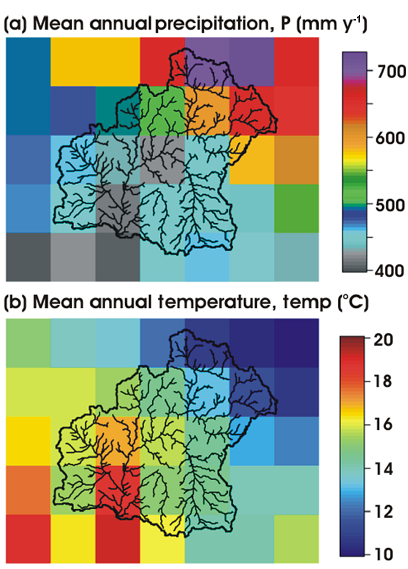
Figure 6. Mean multi-annual distribution of (a) precipitation and (b) air temperature values from 1990–2010 NLDAS time series for the Tonto Creek